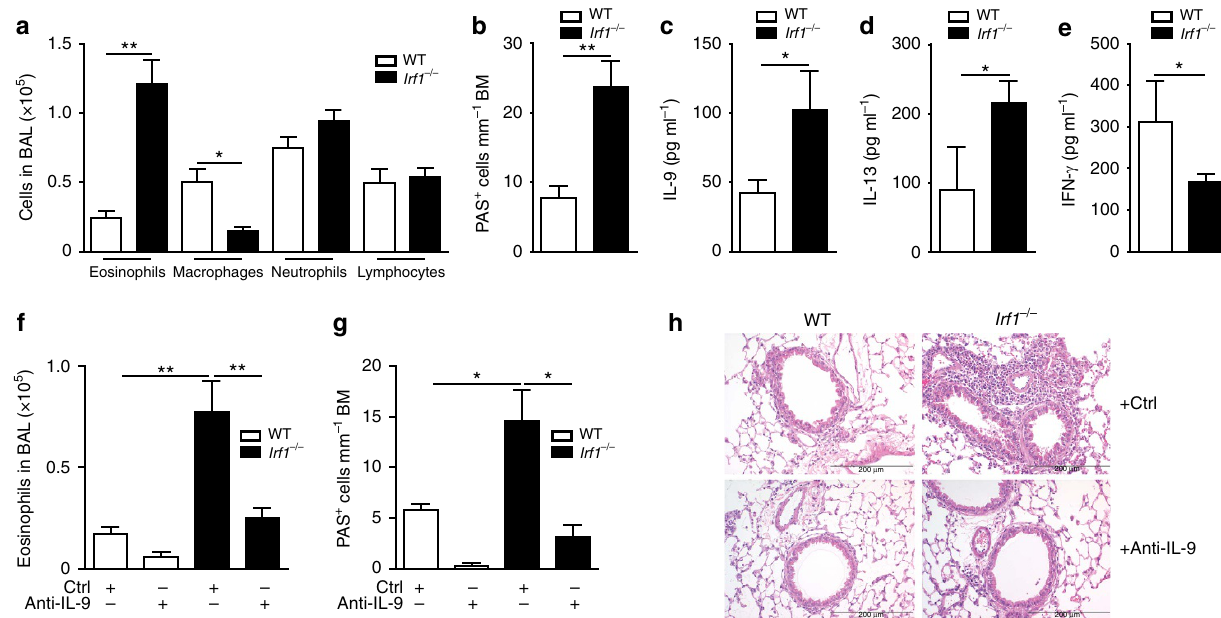
Figure 5 | The IFN- c /IRF1 pathway restricts Th9-dependent allergic airway inflammation. WTor Irf1 (cid:2) / (cid:2) Th9 cells treated with IFN- g were adoptively transferred into Rag2 (cid:2) / (cid:2) mice, which were then challenged with nebulized OVA in the absence or presence of IL-9-neutralizing monoclonal antibodies (anti-IL-9) or control rat IgG (Ctrl) antibodies as outlined in Supplementary Fig. 6. ( a , b , f , g ) Cell numbers in the BAL fluid are displayed. ( b , g ) Numbers of mucus-producing goblet cells evaluated by periodic acid-Schiff staining. ( c – e ) Lung cells were stimulated with 2mM OVA 323–339 for 3 days. IL-9, IL-13 and IFN- g production was determined in supernatants by ELISA. ( h ) Tissue inflammation was evaluated with haematoxylin and eosin staining, original magnification (cid:3) 100. ( a – g ) Data are shown as the mean ± s.e.m. of 10–15 mice combining two independent experiments. ( a – h ) The experiments were repeated four times with consistent results. * P o 0.05, ** P o 0.005 by one-way ANOVA with Tukey´s post-test ( a , b , f , g ) or one-tailed Student’s t -test ( c – e